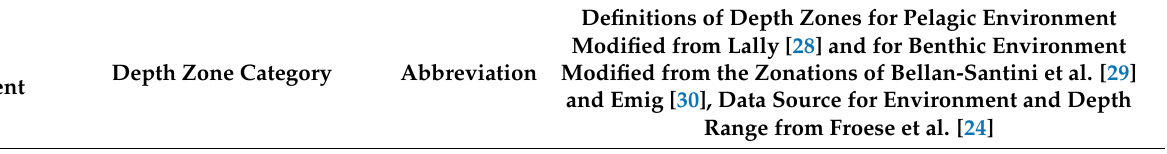
Table 2. The depth zonation categories and definitions. The abbreviations consist of the first letters of depth zone categories for later use in the text and the